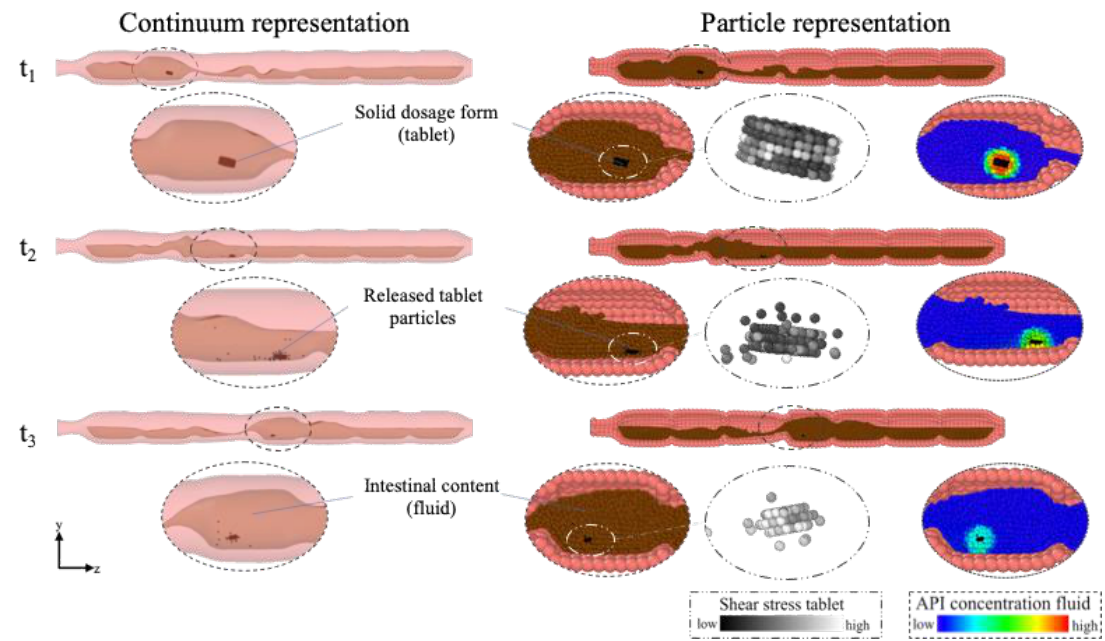
Figure 3. The model is represented in two different forms: ‘Particle representation’ and a more realistic ‘Continuum representation’. This is an example of the dissolution process of a tablet in the colonic environment at three different time steps. Colonic contractions lead to the motion of the fluid and accordingly to the movement of the tablet which dissolves in the intestinal fluid. In the particle representation the shear stress acting on the tablet, and the API concentration in the surrounding of the tablet, i.e., in the fluid is shown.